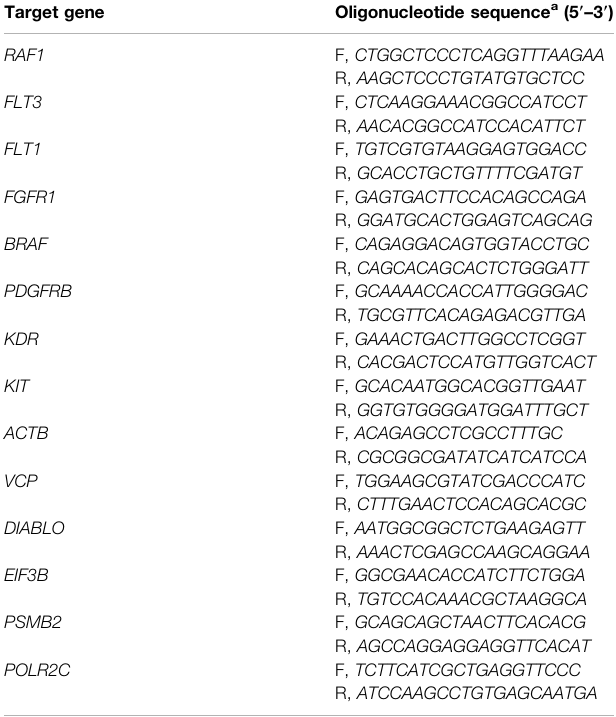
TABLE 4 | Sequences of qRT-PCR primers used in this study Target